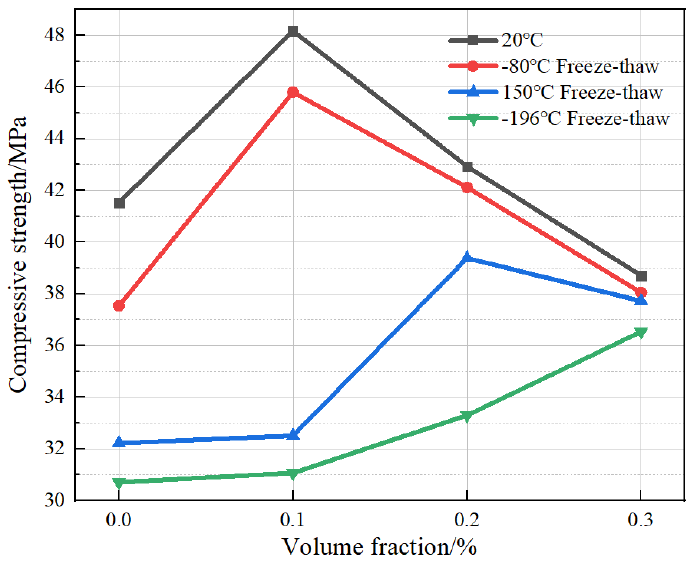
Figure 6. Effect of fiber content on the compressive strength of BFRC.